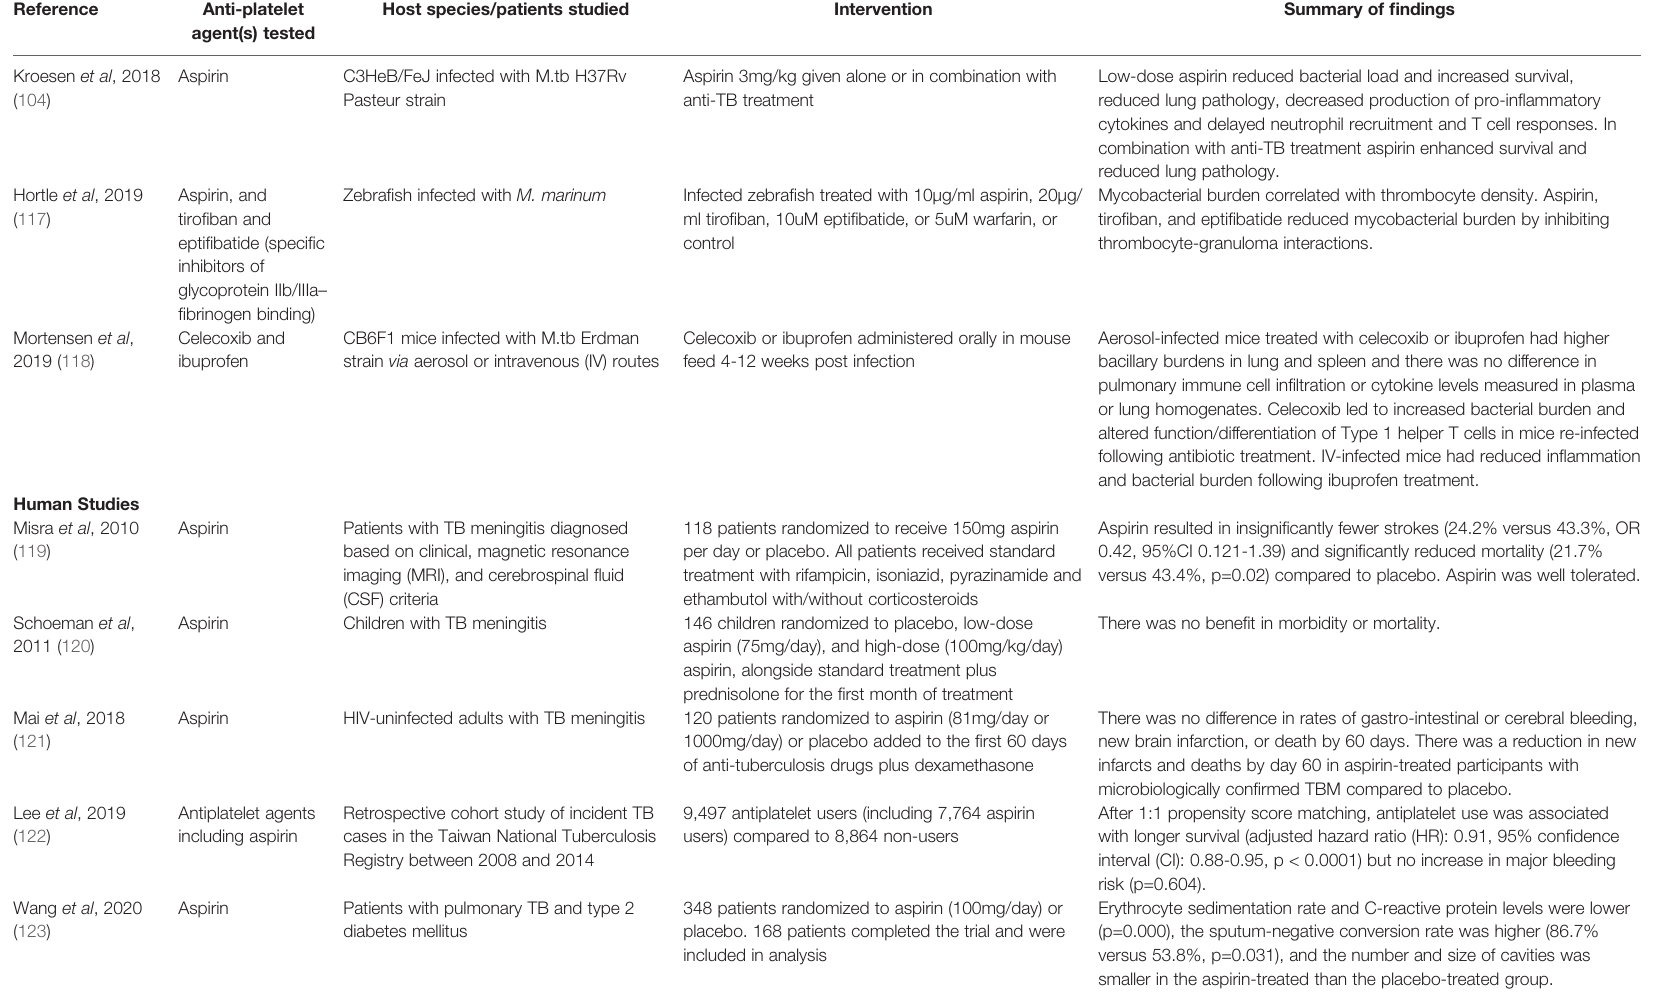
Low-dose aspirin reduced bacterial load and increased survival, reduced lung pathology, decreased production of pro-in fl ammatory cytokines and delayed neutrophil recruitment and T cell responses. In combination with anti-TB treatment aspirin enhanced survival and